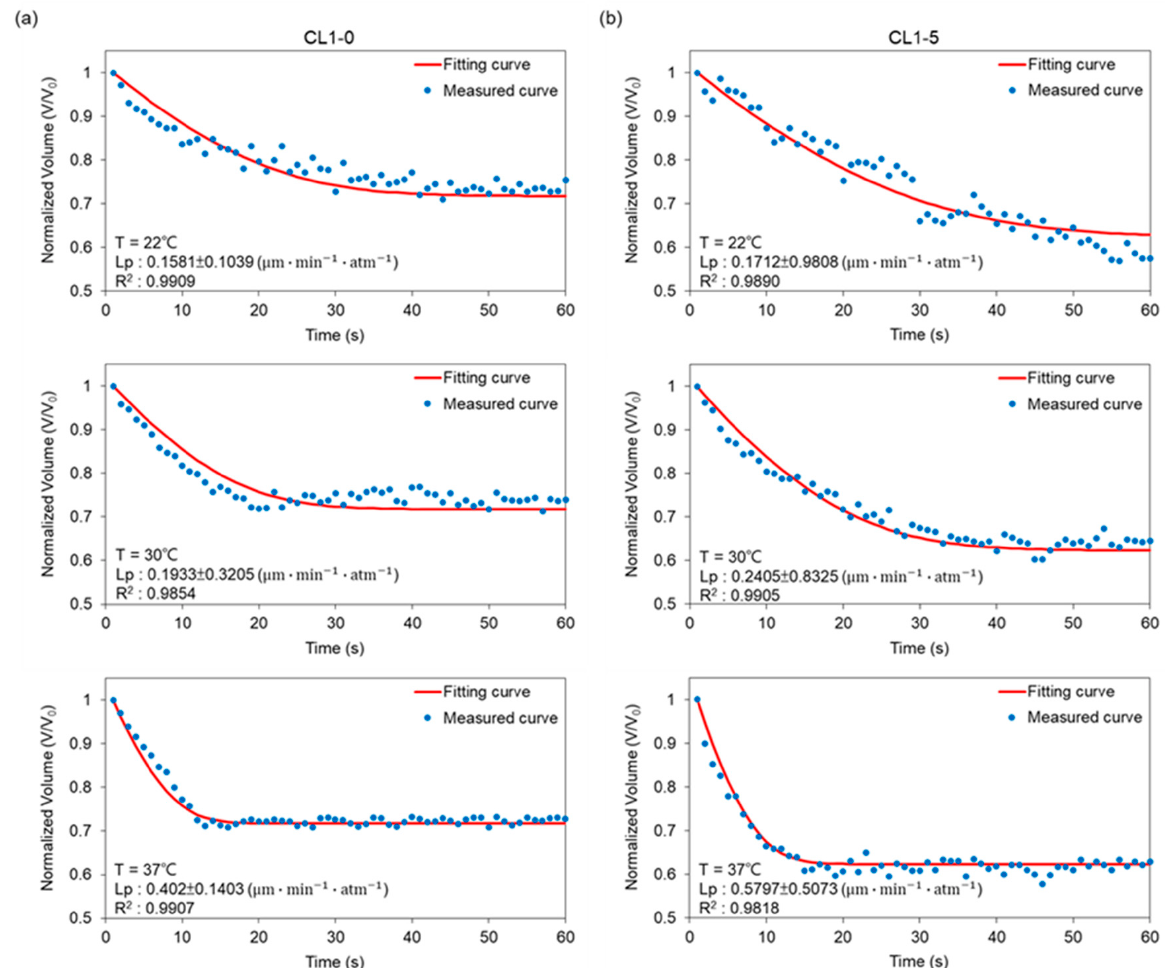
Figure 4. Volumetric changes of ( a ) CL1-0 and ( b ) CL1-5 under exposure to 3× PBS at 22 °C, 30 °C, and 37 °C, respectively. The predicted curve was calculated according to Equation (2).